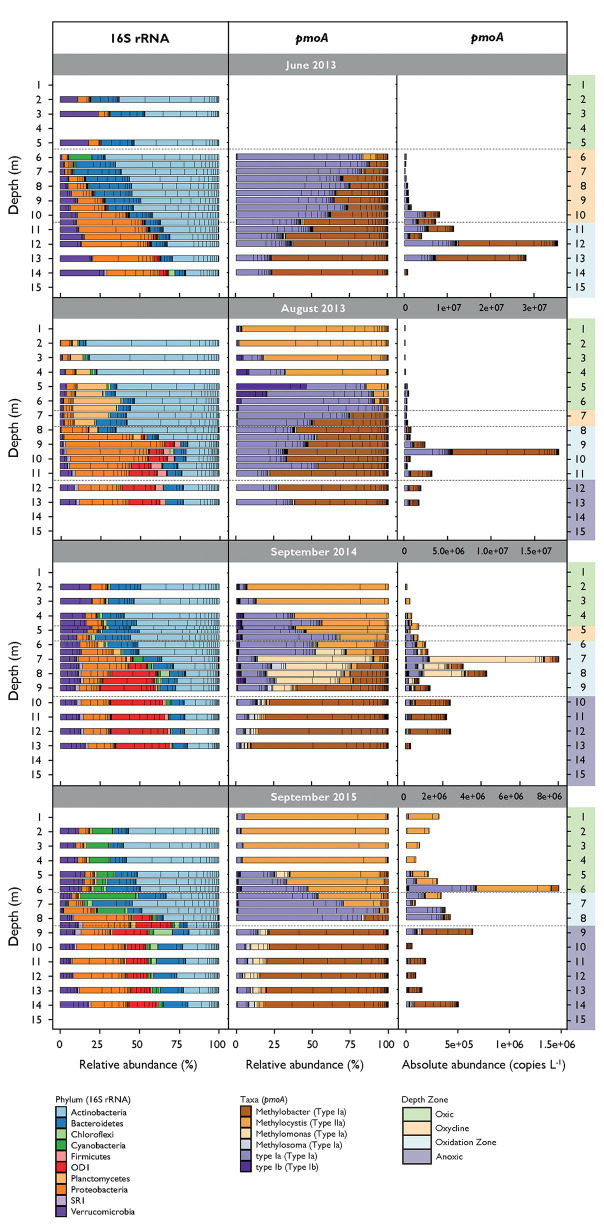
Relative abundance of most abundant bacterial phyla (16S rRNA gene) and methane-oxidizing bacteria (MOB) genera (pmoA) along the depth gradient during the different sampling dates. Bacteria phyla represent sequence reads that occur at least in 10% of the samples and represent at least 1% of total read counts. Bacterial and MOB relative abundances are standardized to the mean sequencing depth. MOB absolute abundances are calculated as relative abundance multiplied by pmoA copy numbers per liter determined by quantitative polymerase chain reaction (qPCR).